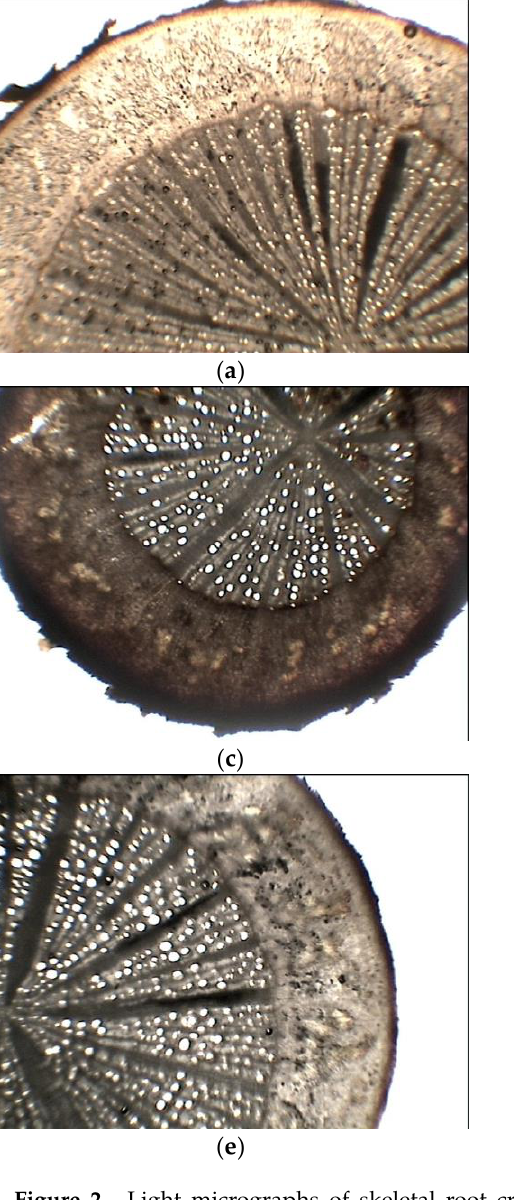
Figure 2. Light micrographs of skeletal root cross-sections of investigated cherry species on a magnification 40× ( a ) European ground cherry ( P. fruticosa ) — SV2 root with secondary structure; ( b ) European ground cherry ( P. fruticosa ) — SV4 root with secondary structure; ( c ) P. cerasus ‘Oblaˇcinska’—OV13 root with secondary structure; ( d ) P. cerasus ‘Oblaˇcinska’—OV17 root with secondary structure; ( e ) P. cerasus ‘Oblaˇcinska’—OV32 root with secondary structure and ( f ) P. cerasus ‘Oblaˇcinska’—OV33 root with secondary